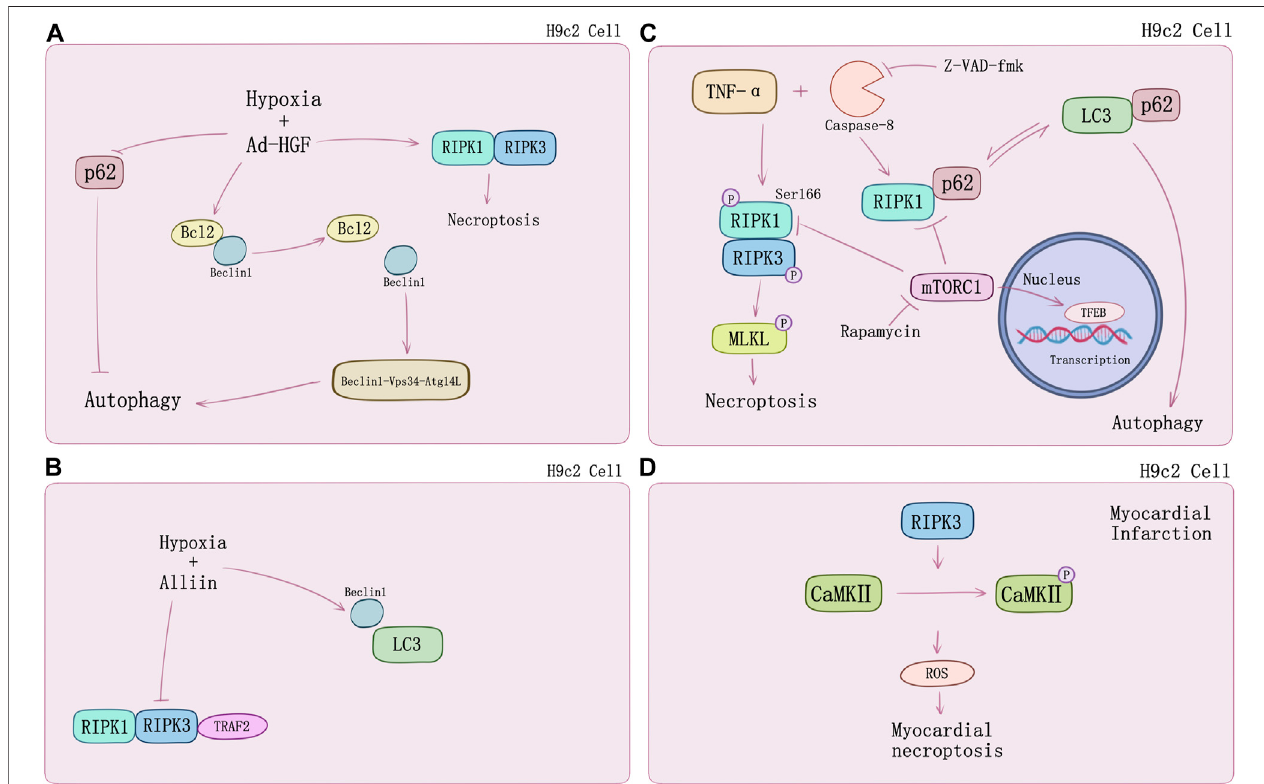
FIGURE 2 | The crosstalk between necroptosis and autophagy in H9c2 cells. (A) HGF promotes autophagy and necroptosis in H9c2 cells under hypoxia by decreasing the binding of Bcl2 to Beclin1 and p62. (B) Alliin decreases hypoxia-induced necroptosis in H9c2 cells and promotes autophagy by increasing the levels of Beclin1 and LC3. (C) TNF- α /zVAD treatment induces necroptosis and switches RIP1-p62 binding to p62-LC3 notably causing suppression of autophagic fl ux. mTOC1 inhibition by rapamycin would suppress TNF- α /zVAD-mediated activation of IKK α / β and attenuates RIPK1/RIPK3-mediated necroptosis by suppressing RIP1- Ser166 phosphorylation. Rapamycin can induce TFEB nuclear translocation and promote autophagy in a TFEB-dependent manner. (D) RIP3-induced CaMKII phosphorylation and the release of ROS.